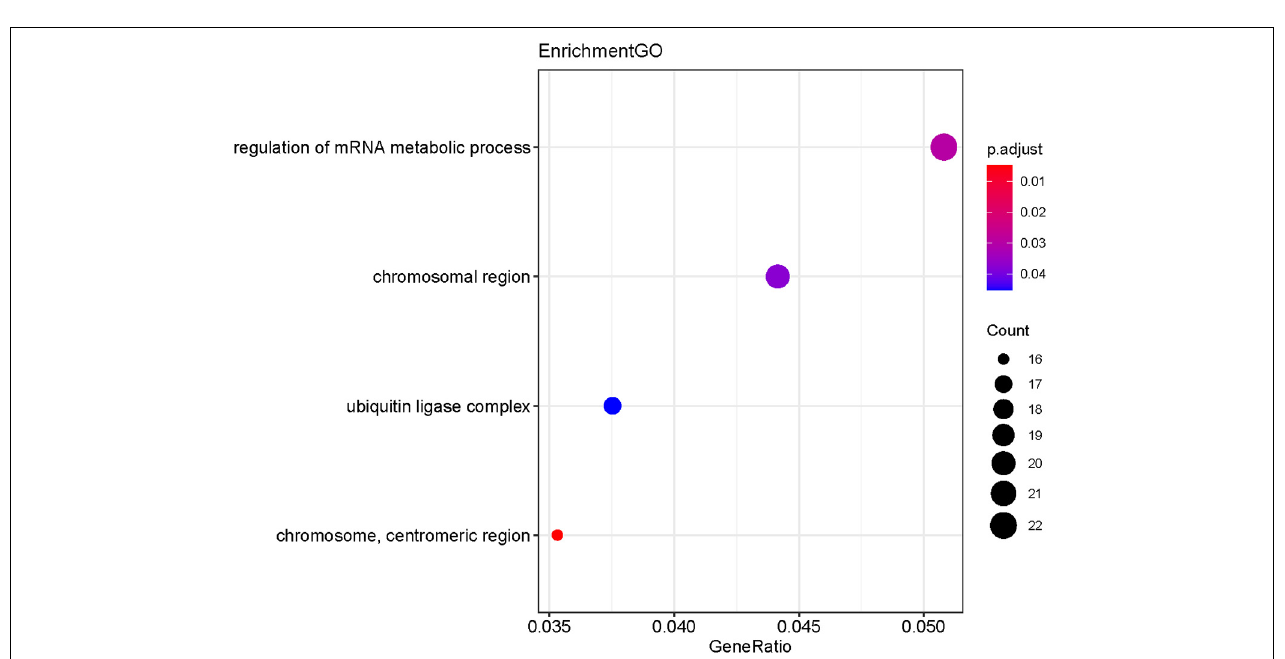
FIGURE 5 | The relationship between miRNA expression levels in serum and with pathological types. Serum miR-492, miR-590-3p, and miR-631 miRNAs did not show significant differential expression in adenocarcinoma and squamous cell carcinoma.